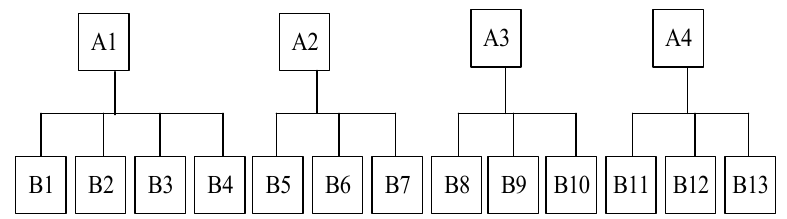
Figure 3. Hierarchy of the proposed monitoring index system.